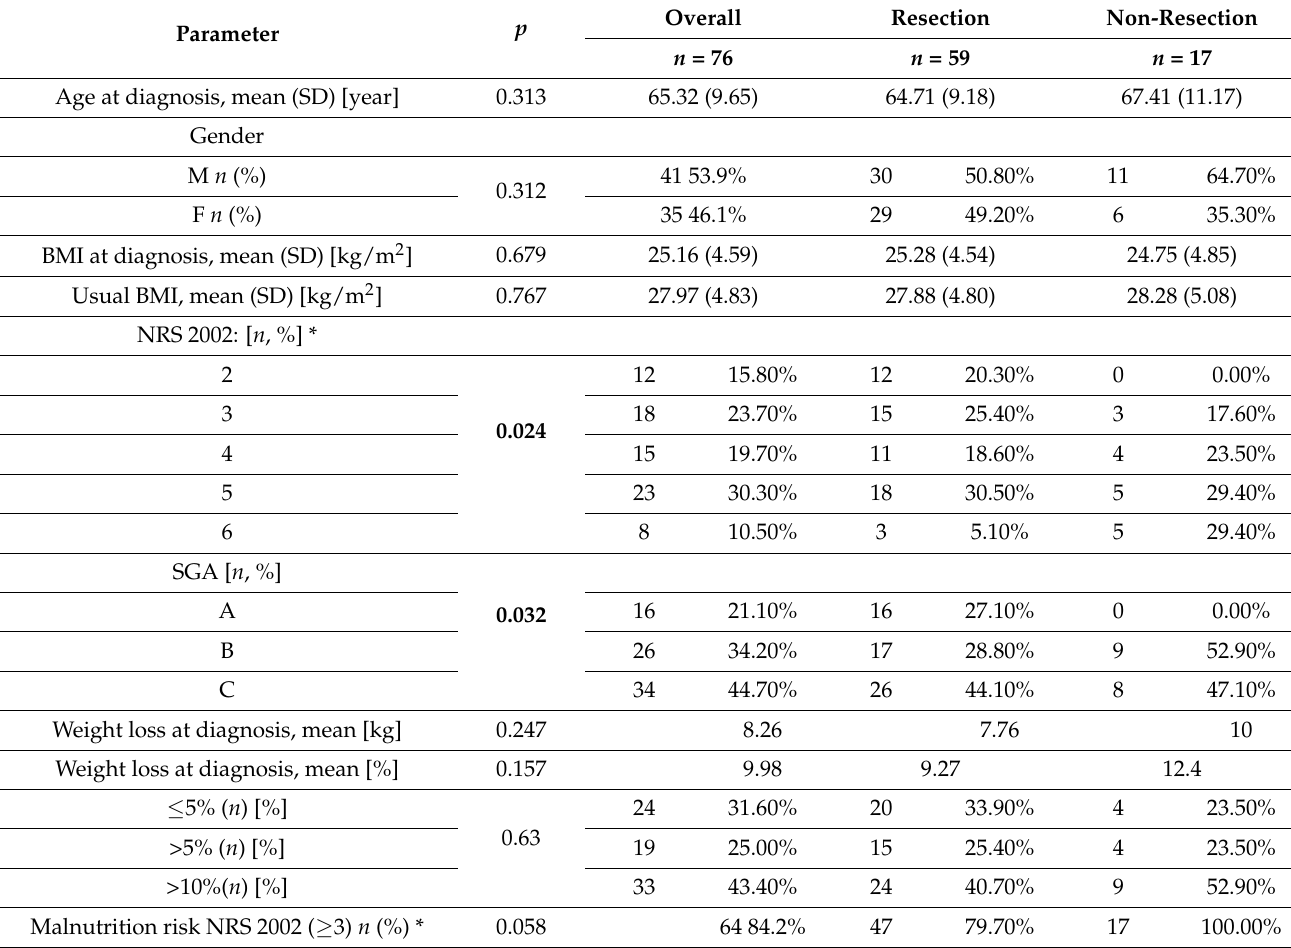
Table 1. Clinicopathological and nutritional assessment characteristics between resection and non-resection tumor groups.